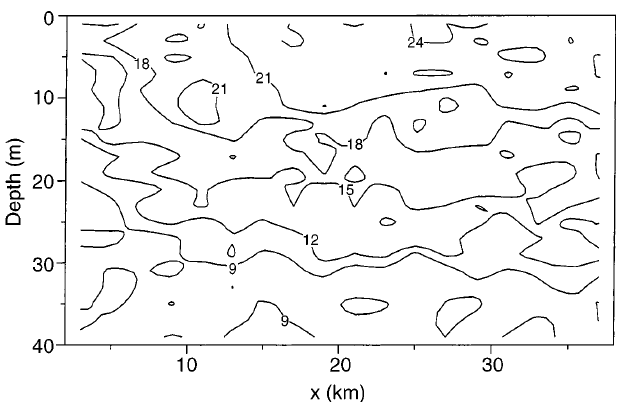
Fig. 11. Assimilated and noisy temperature data ( (cid:176) C) of the coastal upwelling, at t (cid:136) 48 h , obtained by addition of a white and gaussian noise with an rms equal to 2